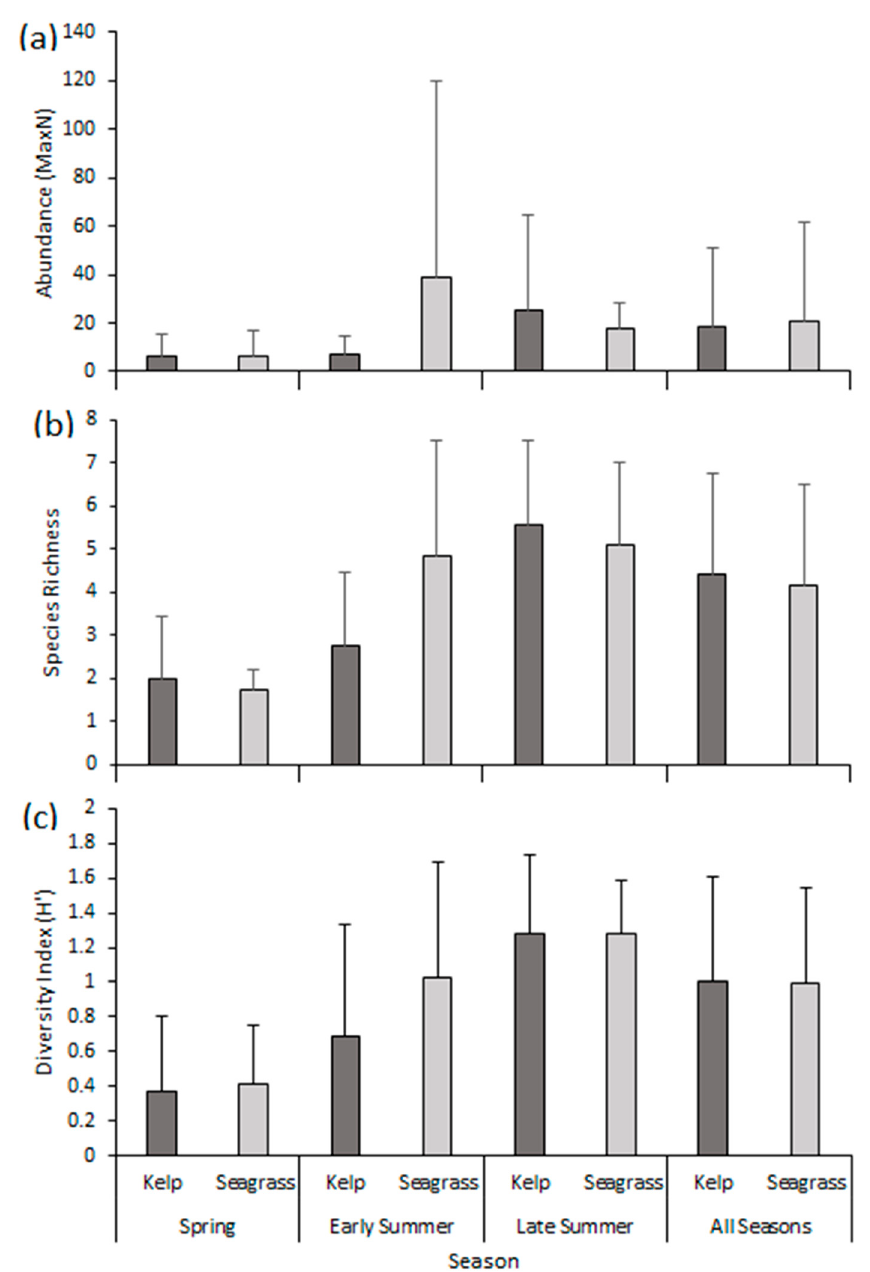
Figure 2. Metric of ( a ) the relative fish abundance (MaxN), ( b ) species richness, and ( c ) Shannon Weiner diversity index (H’) from seagrass and kelp sites using mono BRUVs in the UK during 2017. Mean data are shown with standard deviation bars. “All Seasons” shows an average across all data.